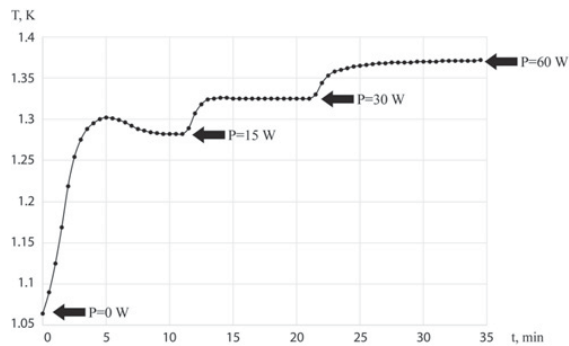
Figure 7. Experimental results for the full-scale model of UCN source.